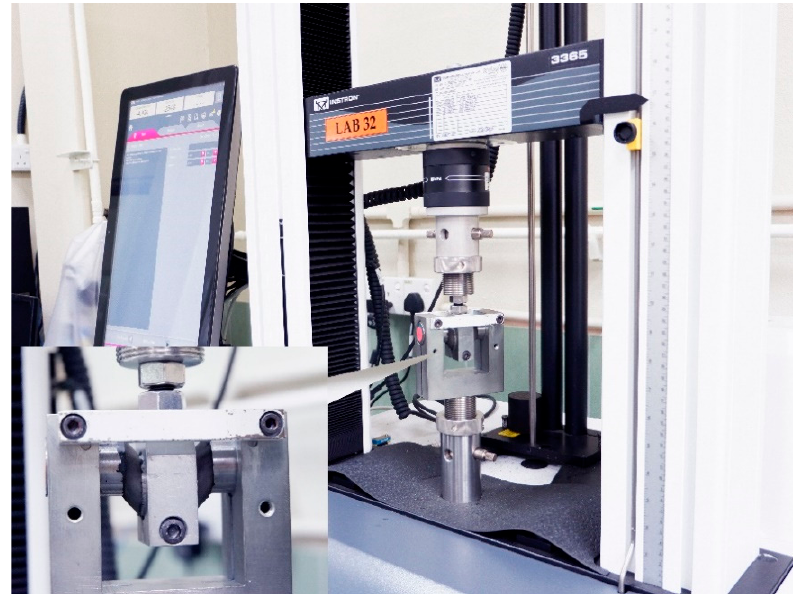
Figure 2. Double-shear testing using INSTRON servo-hydraulic testing machine.